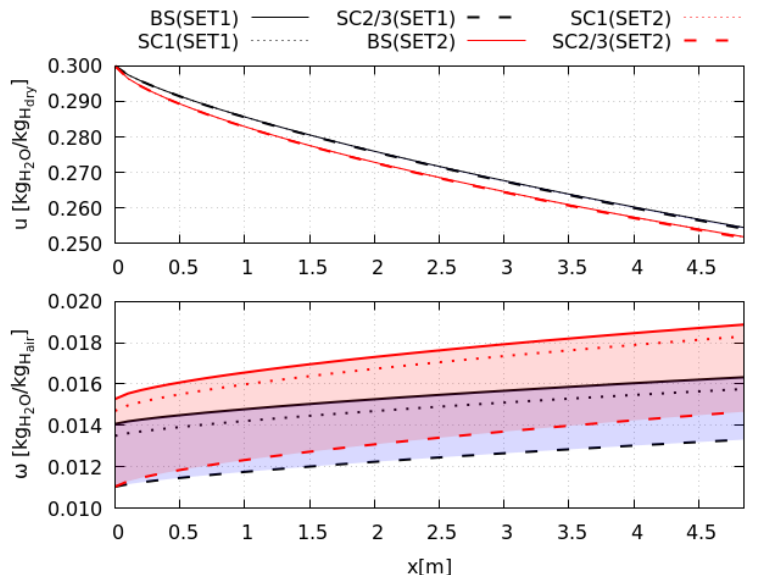
Figure 13. Effects of combustion on the u and ω values compared among different sets and